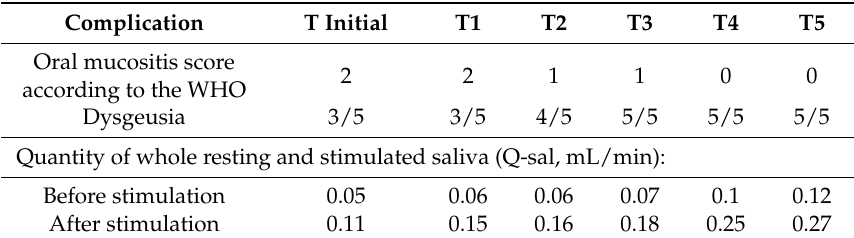
Table 1. Results of the assessments of oral mucositis, dysgeusia, and oral